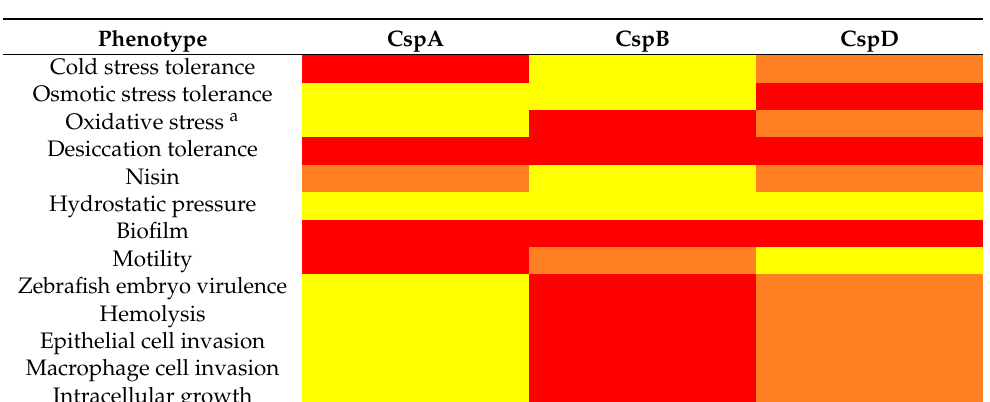
Table 1. Hierarchical trends of Csps influence on selected phenotypes in L.